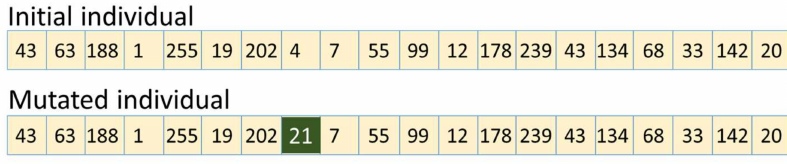
Figure 6. Mutation operator